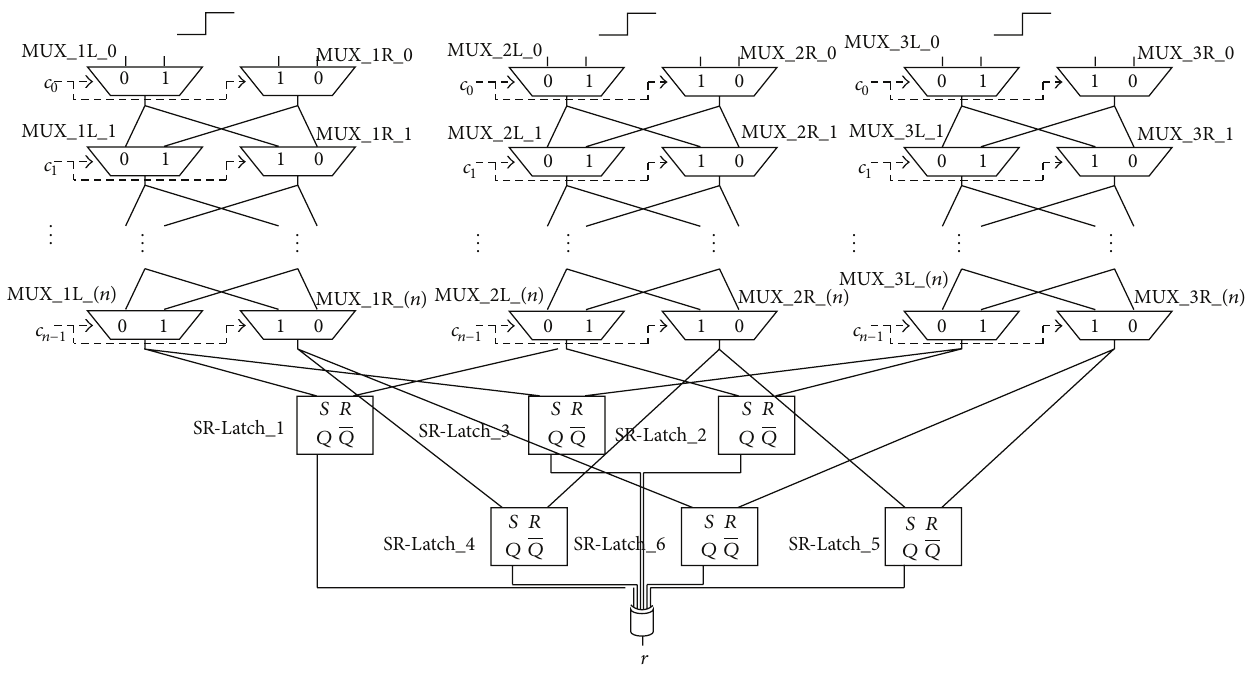
Figure 8: Structure of the 3-1 Double Arbiter PUF.